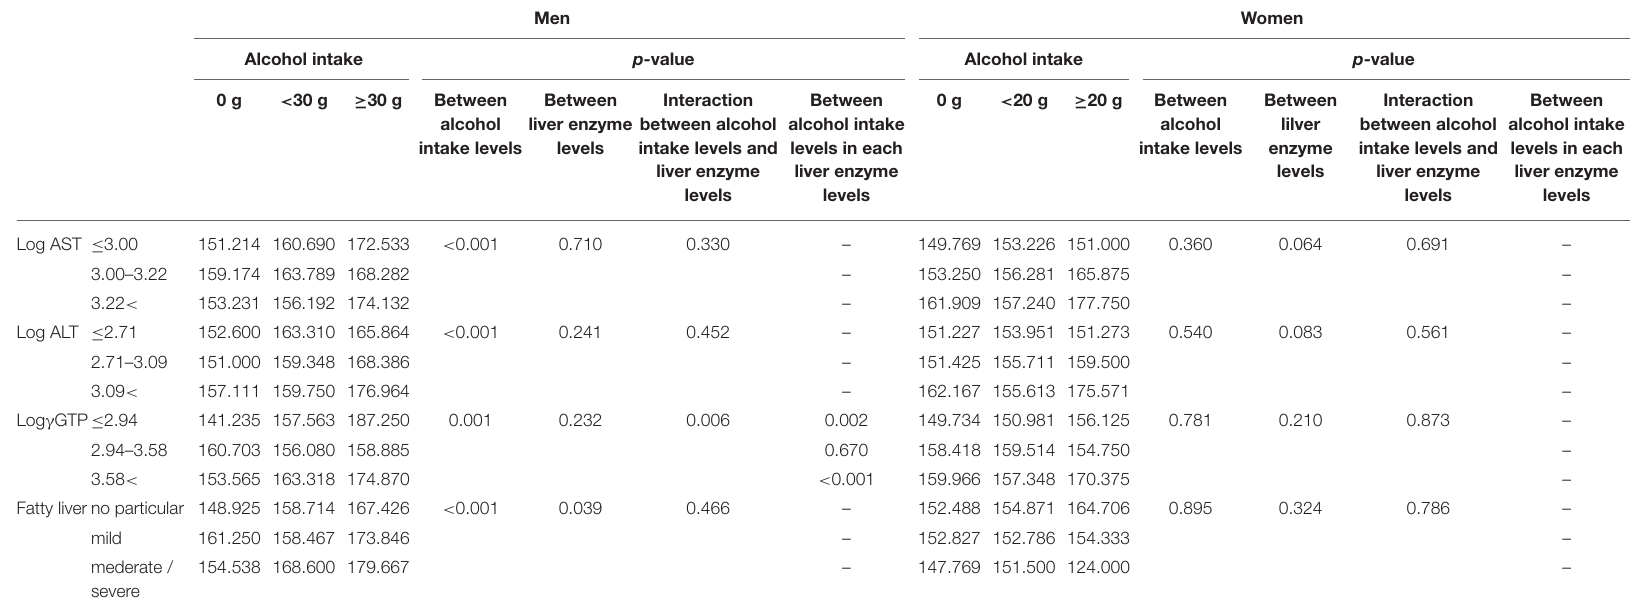
TABLE 4a | Comparison of serum selenium levels ( µ g/L) among participants with different alcohol intake levels and different liver enzyme/fatty liver